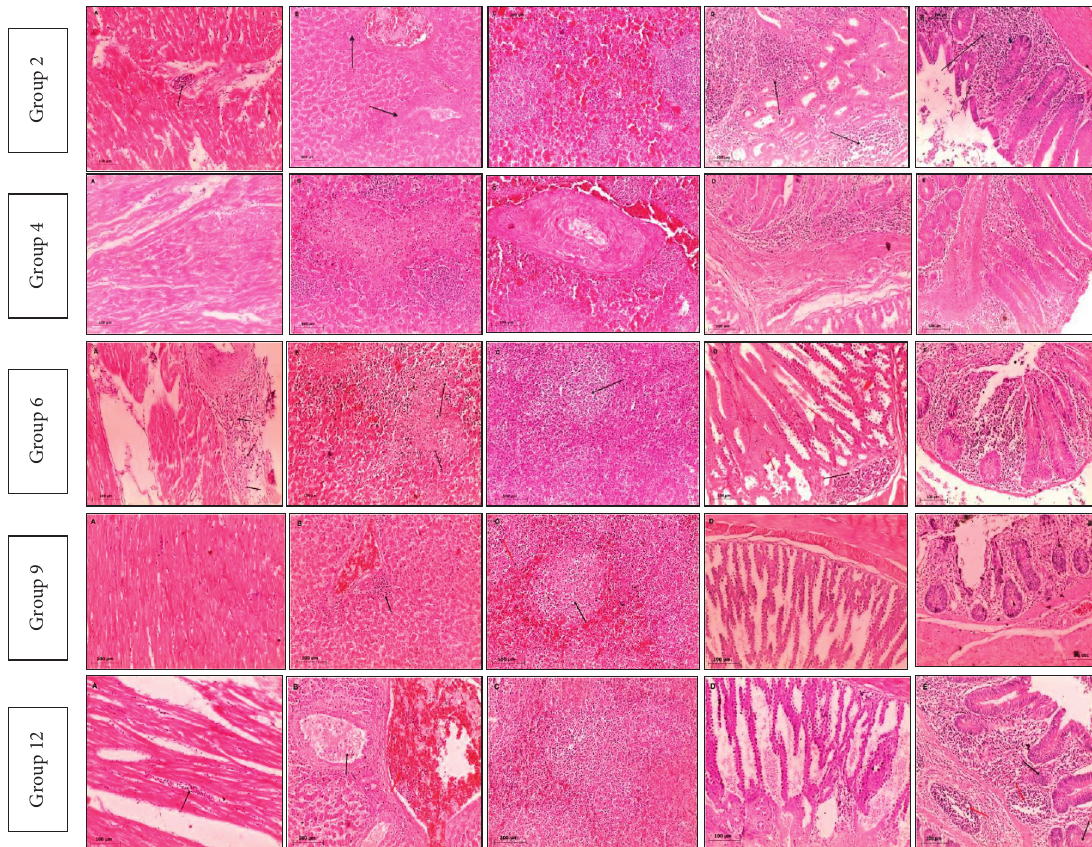
Figure 3: Microscopic picture of infected groups with SXT Salmonella Enteritidis sensitive